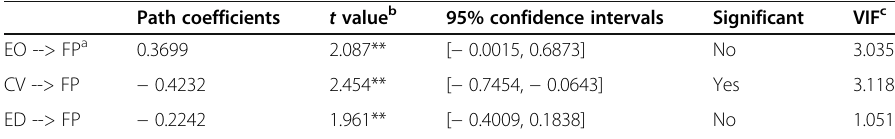
Table 7 Structural model